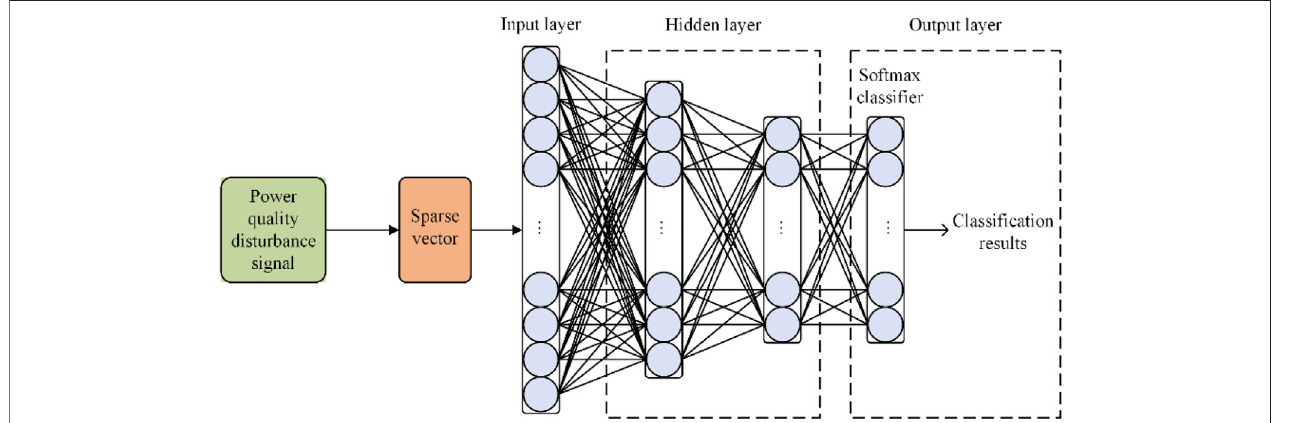
FIGURE 3 | Structure of CS-DL